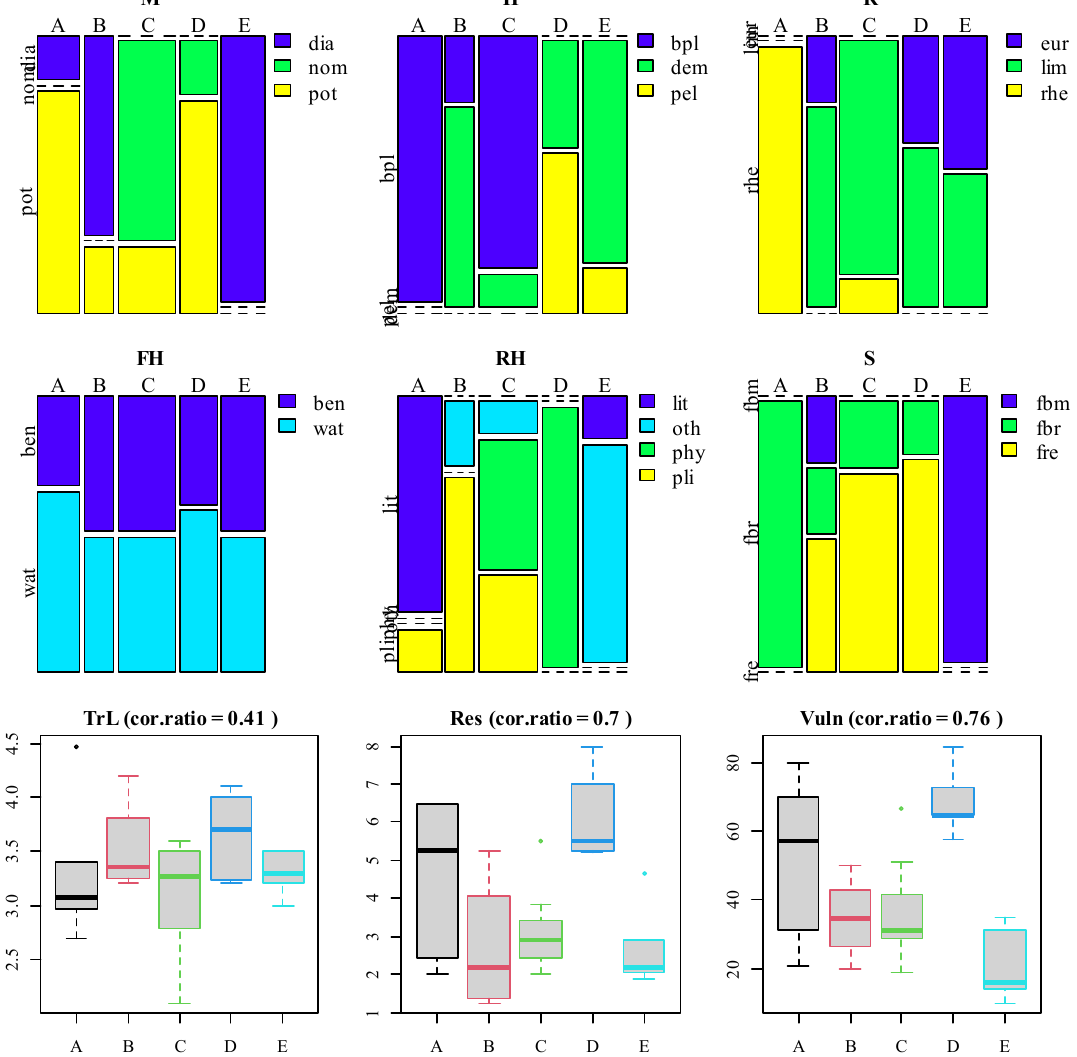
Figure 7. Distribution and variation of species traits in clusters: M—pot are potamodromous, dia are diadromous, and nom are no migration fish species; H—pel are pelagic, bpl are benthopelagic, and dem are demersal fish species; R—rhe are rheophilic, lim are imnophilic, and eur are eurytopic fish species; FH—wc are water column, ben are benthic fish species, RH—lit are lithophilic, phy are phytophilic, pli are phyto-lithophilic, spa are psammophilic, and oth are other fish species; S—fre are freshwater species, fbr are freshwater-brackish species, fbm are brackish- marine species; TrL is the trophic level; Res is the resilience, Vuln is the vulnerability.